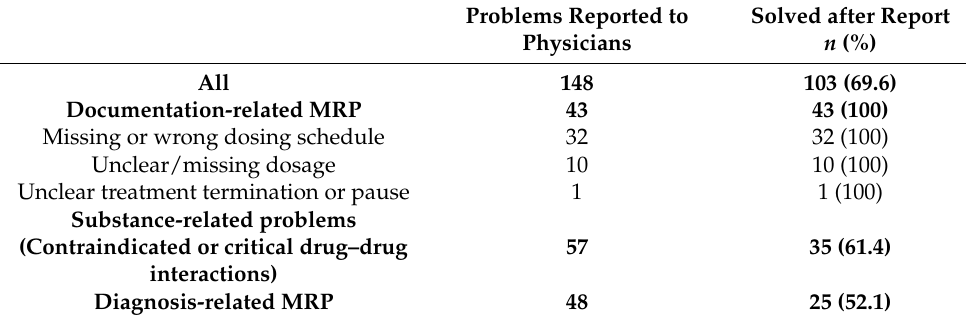
Table 3. MRP reported to physicians (MRP alerts) and